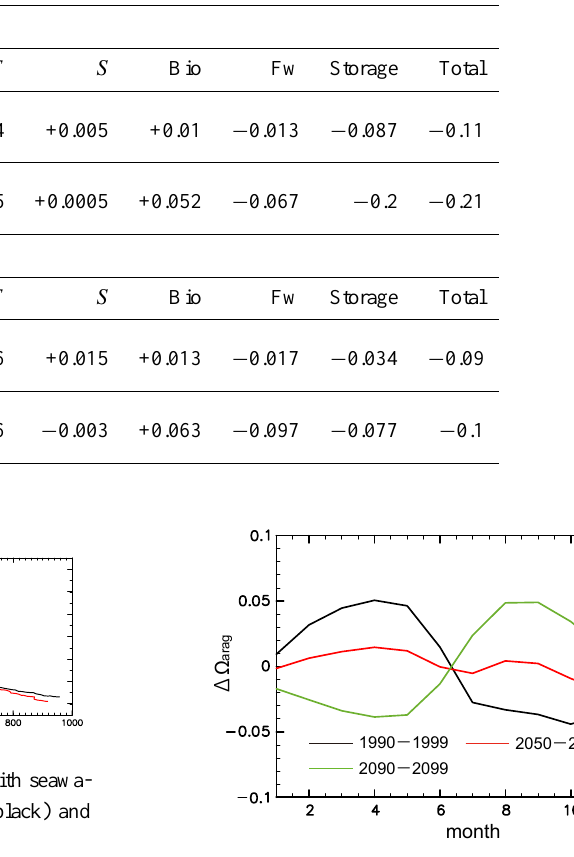
Table 2. Difference in projected changes in the annual mean (cid:127) arag from 1850 to (a) 2045 and (b) 2090 in the top 50m of the Arctic Ocean between “C 4 MIP” and new “CMIP5”. The total change is divided into 5 factors as mentioned in Fig. 6.